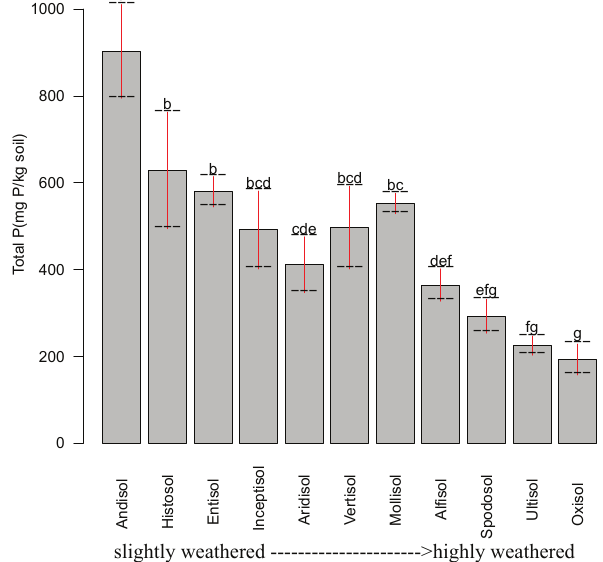
Fig. 2. Mean total soil P in each soil order with one standard er- ror. Different letters indicate significant differences of total soil P among soil orders at p < 0 . 05. Slightly weathered soils: An- disols, Histosols, Entisols, Inceptisols; Intermediately weathered soils: Aridisols, Vertisols, Mollisols, Alfisols; Highly weathered soils: Ultisols, Spodosol,